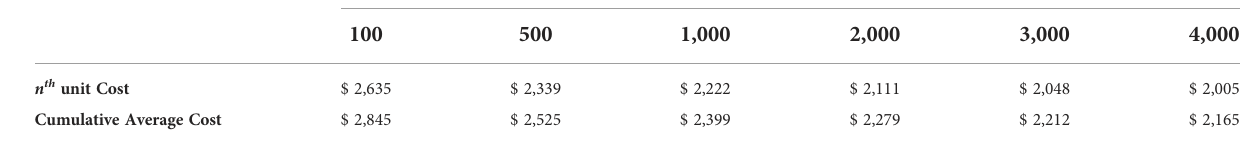
TABLE 2 Price variation for increased production of $4,000 deck unit with a 95% learning rate.